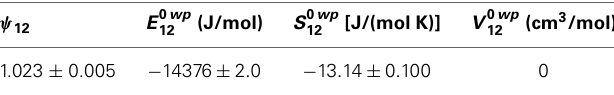
Table 8 | NETGP-NRHB parameters for PEEK-water mixture as obtained from fitting of experimental sorption isotherms.